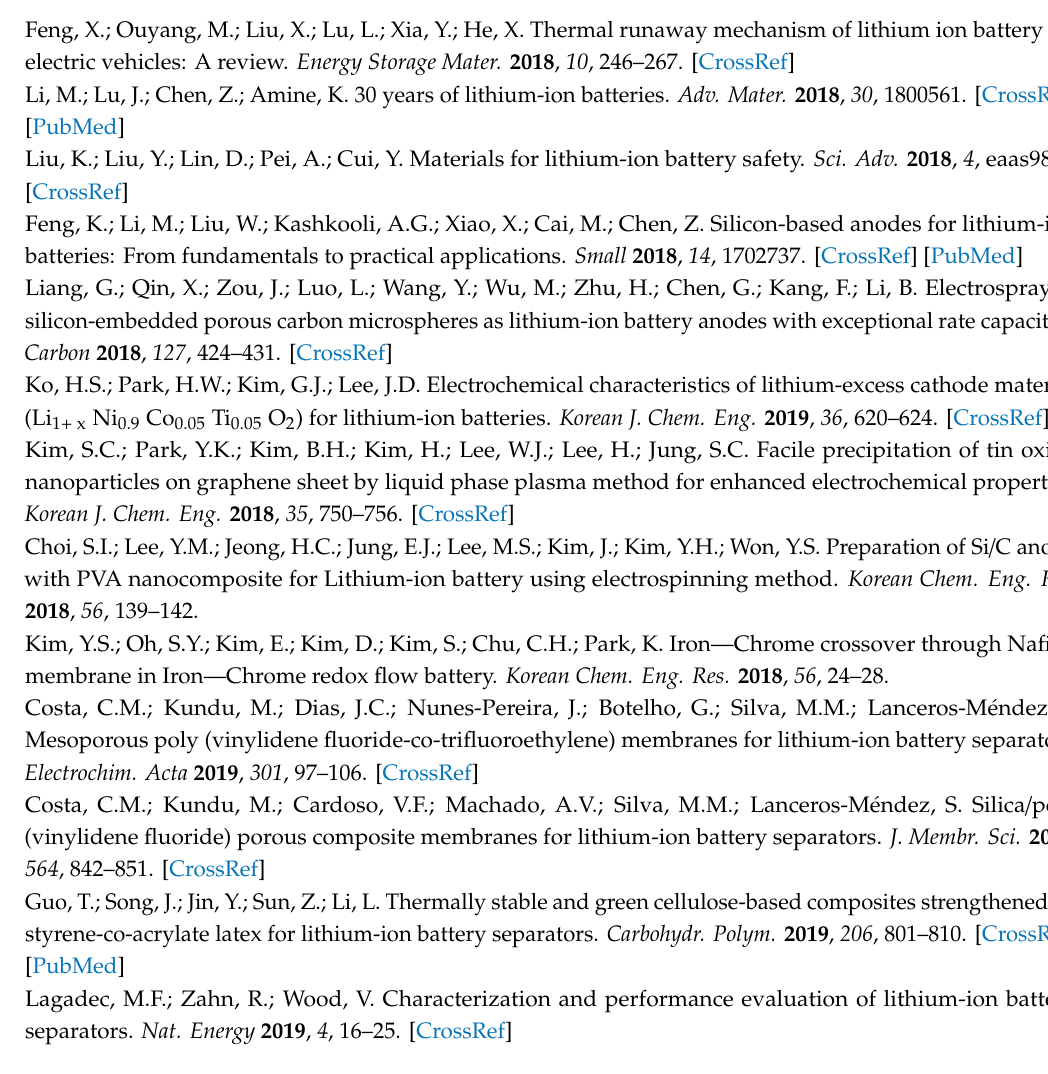
Figure S1: EDS of PL Membranes; Figure S2: Elemental Mapping of P-L30; Figure S3: Stress-Strain curves of PL membranes; Figure S4: Heat treatment at 170 ◦ C of (a) P-L30 (b) celgard separator (Above — Before Heat treatment; Below—After Heat treatment); Figure S5: Cyclic Voltammetry of PL membranes; Figure S6: FESEM image of P-L30 membrane after 200 cycles of Charge and